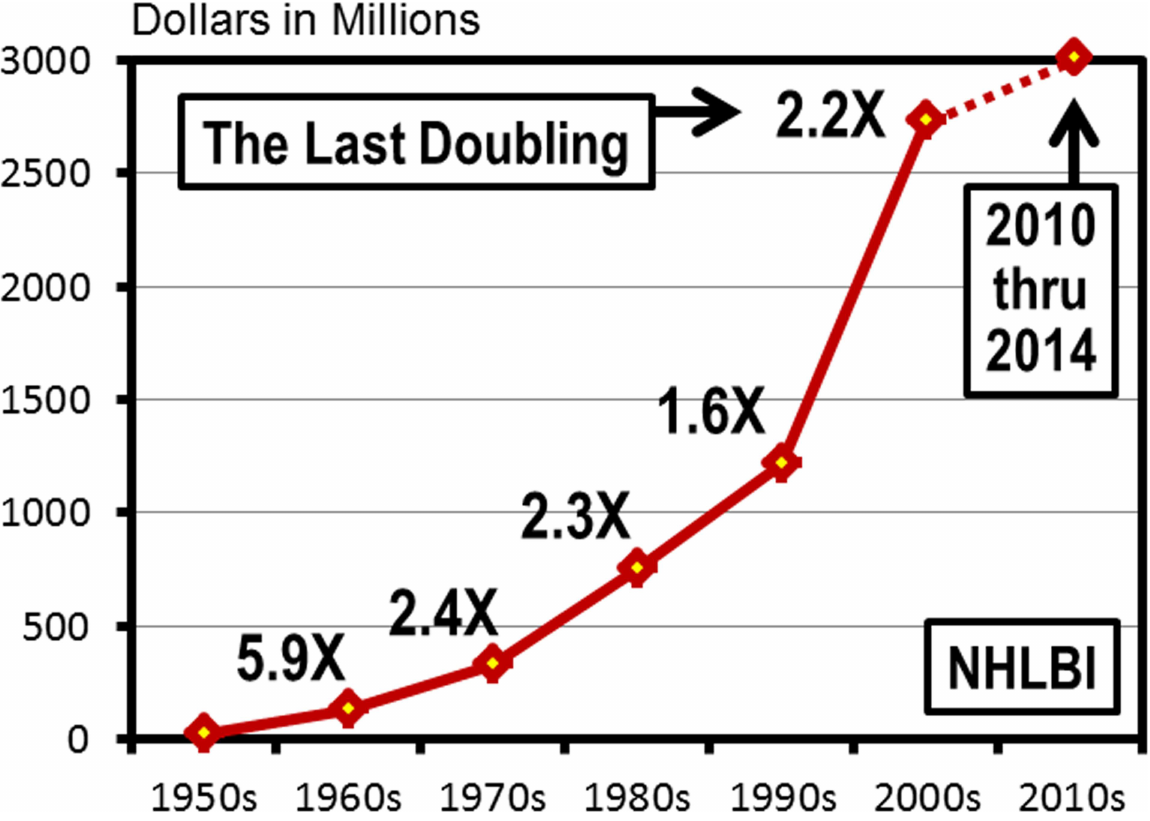
Fig 1. Five Decadesof Exponential Growth in Congressional Appropriations at NHLBI. Average yearly congressional appropriation per decadefor the NationalHeart, Lung, and Blood Institute from 1950 through 2014[1]. The numbers adjacent to the data points indicatethe magnitude of appropriation increase relativeto the